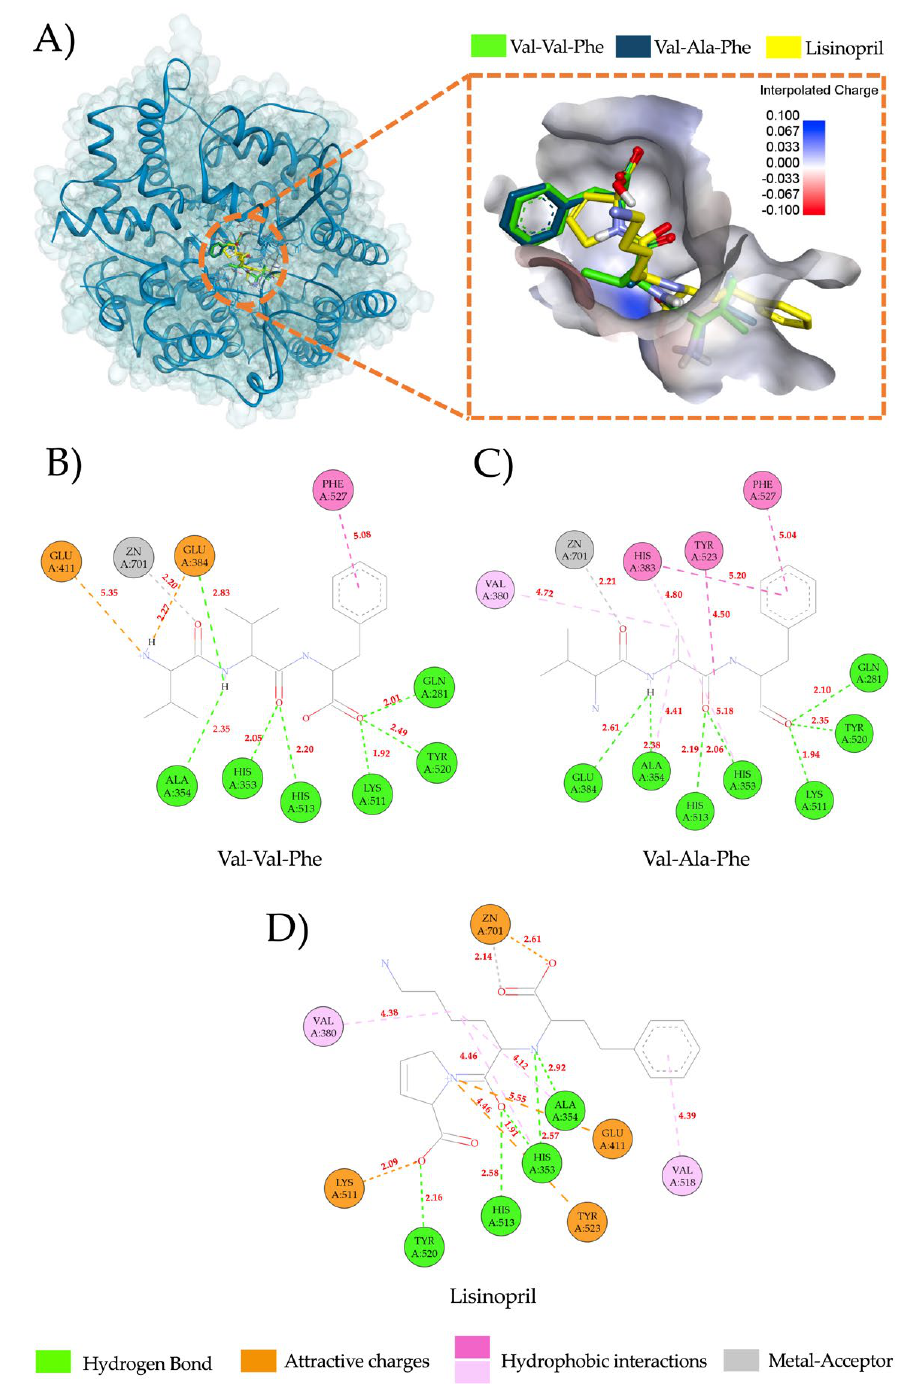
Figure 3. Docking modeling visualization of VVF and VAF tripeptide with the active site of ACE-I. ( A ) Overlap of docking results of VAF and VVF with ACE-I-lisinopril complex (PDB: 1O8A). The box is the close-up view of the overlap poses of VAF, VVF, and lisinopril interacting with the ACE-I pocket. The peptides are presented in the stick model. VVF (Val-Val-Phe): Green sticks; VAF (Val-Ala-Phe): Blue sticks; Lisinopril: Yellow sticks. ( B ) Docking modeling visualization of VVF with the active site of ACE-I. ( C ) Docking modeling visualization of VAF tripeptide with the active site of ACE-I. ( D ) Docking modeling visualization of Lisinopril with the active site of ACE-I. Interactions distances (Å) are shown in red